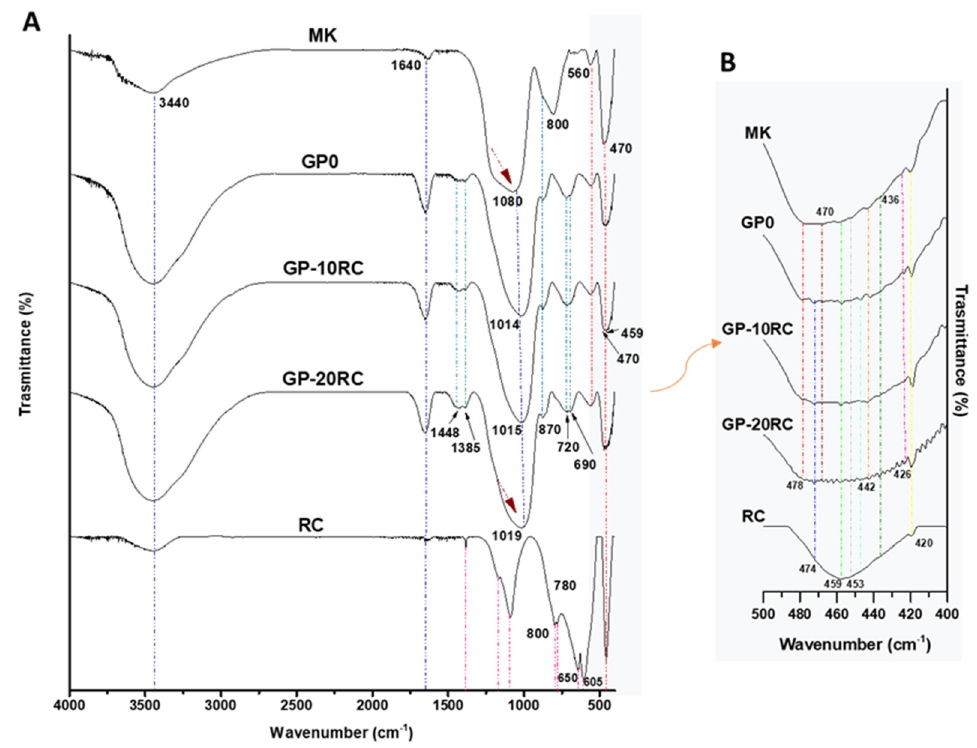
Figure 4. ( A ) FT-IR spectra of MK powder, GP0, GP-10RC, GP-20RC and RC powder. ( B ) Focus on 500–400 cm − 1 IR range.